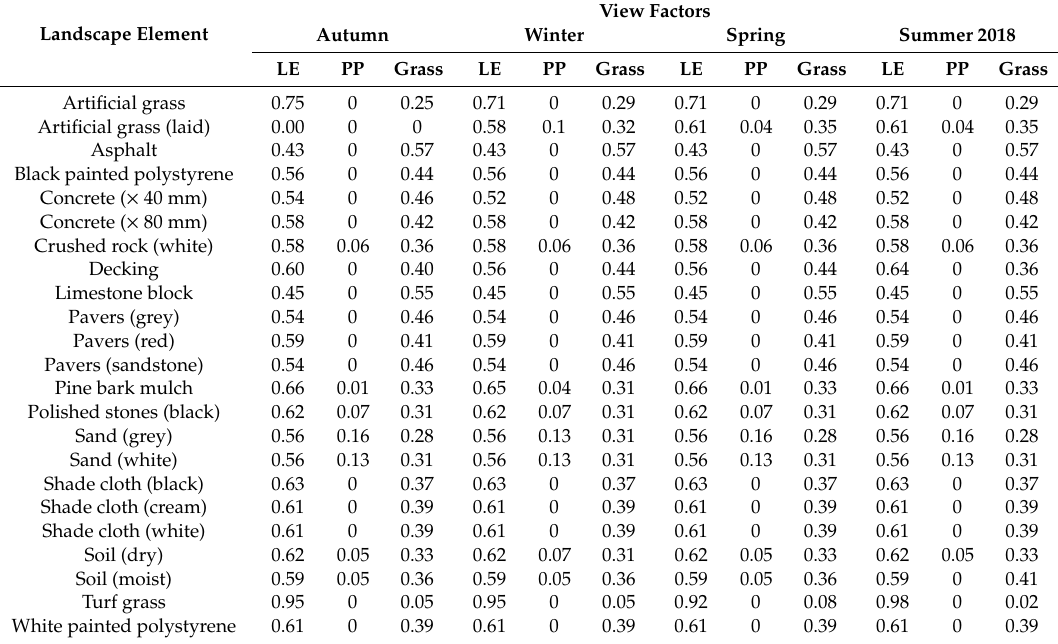
Table 4. Seasonal radiosity view factors to the iButton surfaces from the small phase 1 landscape elements (LEs), and from the surrounding polypropylene (PP) and turf grass. View Factors Landscape Element Autumn Winter Spring Summer 2018 LE PP Grass LE Artificial